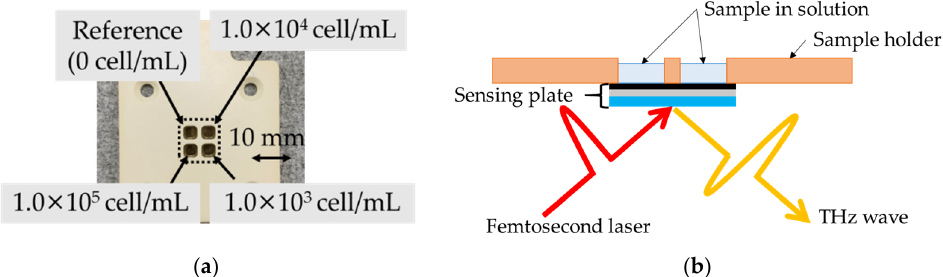
Figure 4. ( a ) Sensing plate with four wells. The concentrations of cells in each well are indicated in the photo. ( b ) Cross-section diagram of the sensing plate with wells.